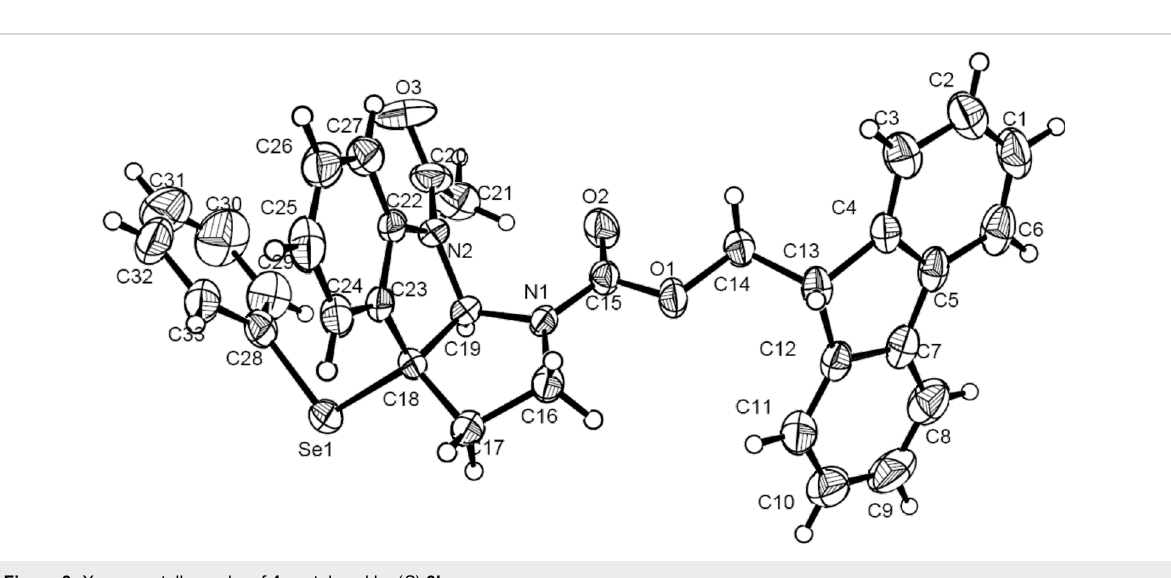
Figure 3: X-ray crystallography of 4a catalyzed by ( S )- 3b